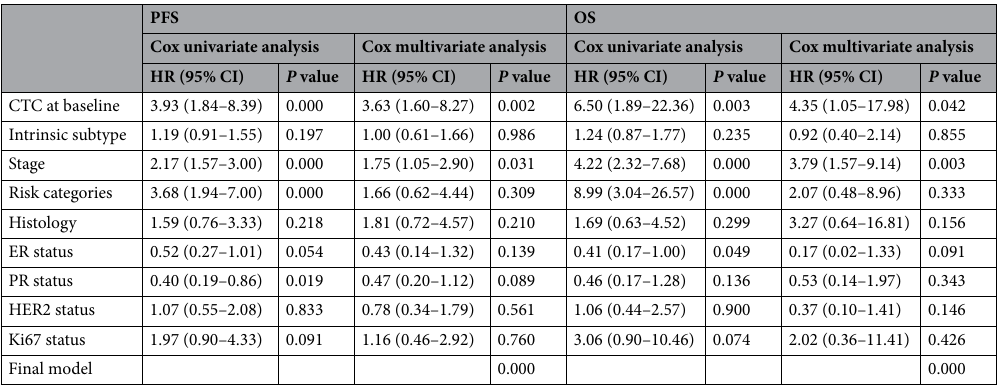
Table 2. Cox univariate analysis and multivariate analysis of CTCs at